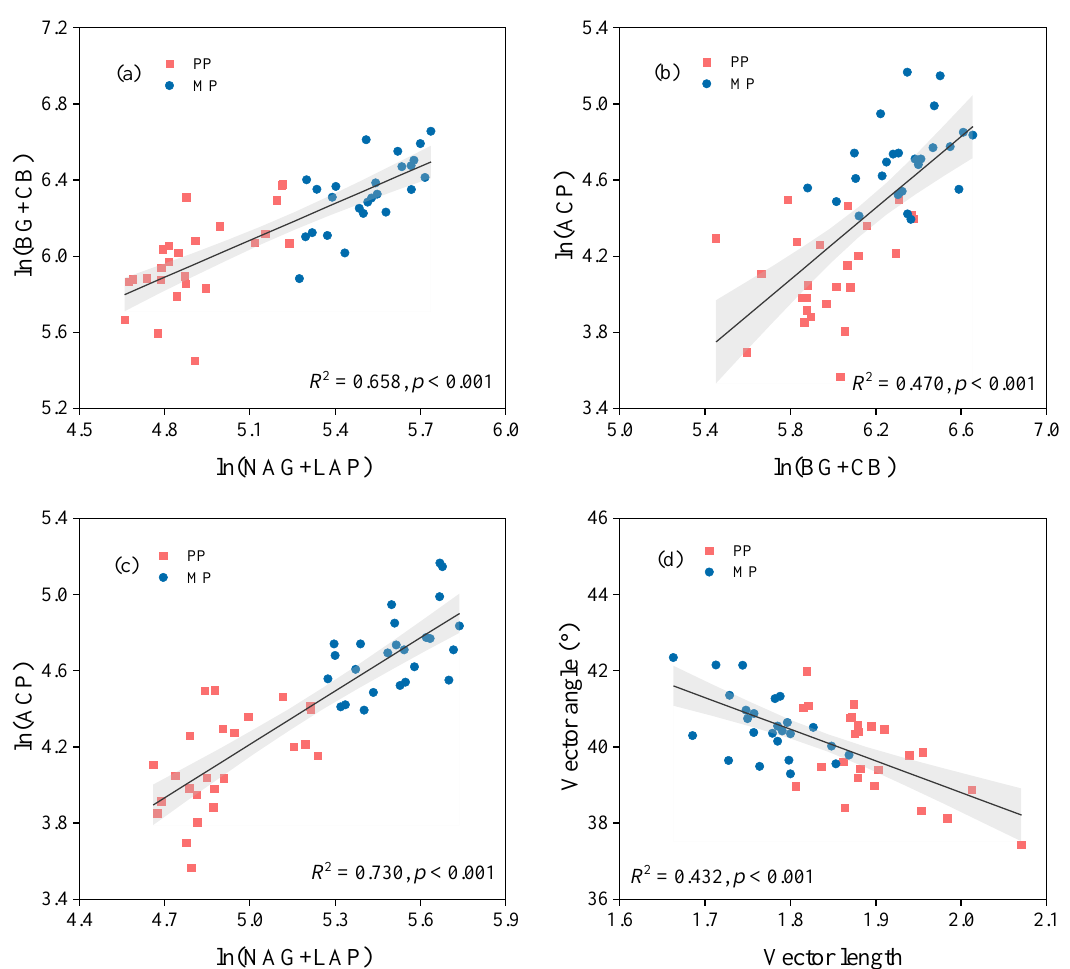
Figure 4. Relationships among soil extracellular enzymatic activity (EEA) ( a – c ), and between vector length (VL) and vector angle (VA) ( d ).